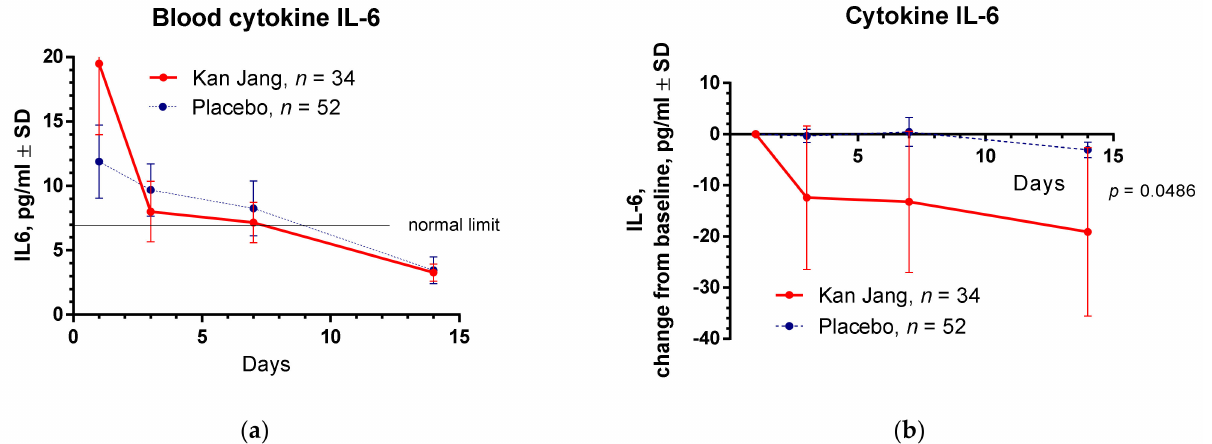
Figure 8. ( a ) Concentration of IL-6 (mean ± SD) in the blood of patients in group A (Kan Jang) and group B (placebo) over the time from Day 1 to Day 14. ( b ) The changes from the baseline of the levels (mean ± SD) of cytokine IL-6 in the blood of patients in group A (Kan Jang) and group B (placebo) over the time from Day 1 to Day 14. Between-groups comparison of the changes in the level of cytokine IL-6 in the blood from the baseline over time shows a significant difference ( p = 0.0486) between groups A and B. The Kan Jang ® treatment has a statistically significant effect on cytokine IL-6 in blood compared to the